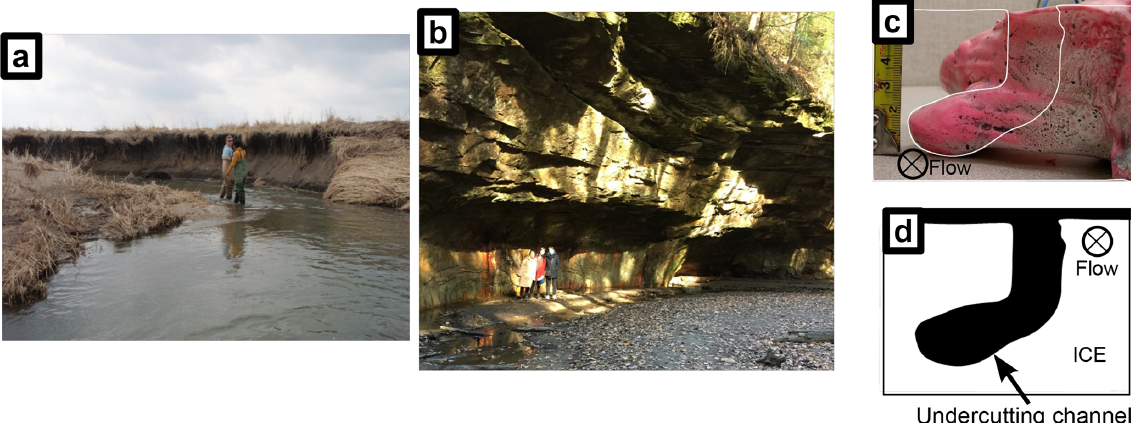
Figure 6. Undercut bank in (a) an alluvial river, (b) a bedrock river, (c) a rubber mold of a laboratory meltwater channel, and (d) a schematic of the laboratory meltwater channel in (c) . Image information: (a) Embarras River, Indiana, USA; picture by Gary Parker. (b) Turkey Run, Indiana, USA; picture by Gary Parker (c) Picture by Roberto